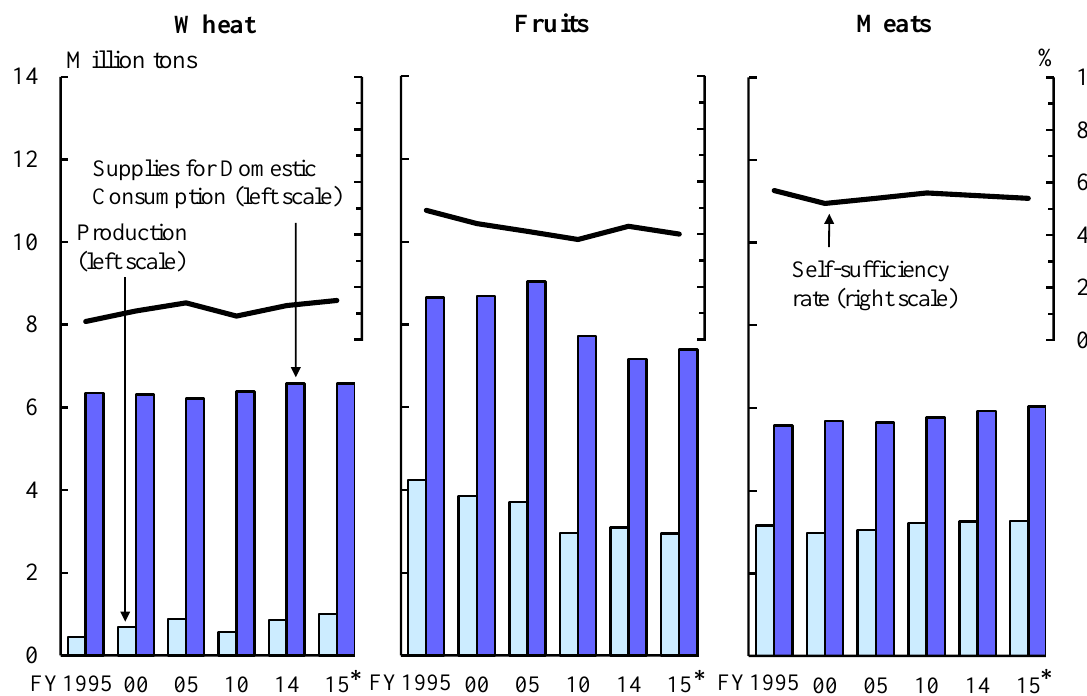
Self-Sufficiency Rates for Selected Categories of Agricultural Produce